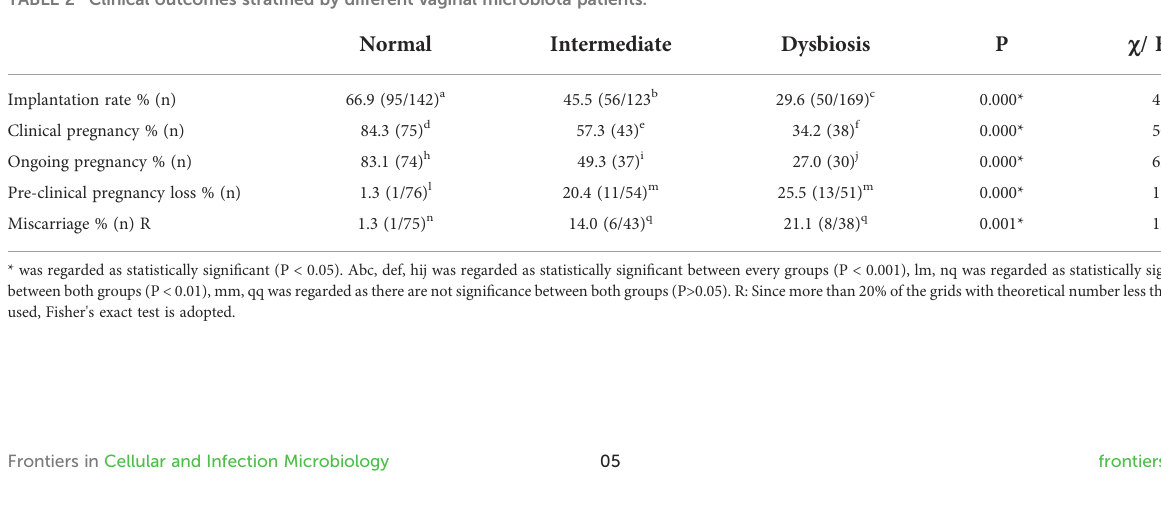
TABLE 2 Clinical outcomes strati fi ed by different vaginal microbiota